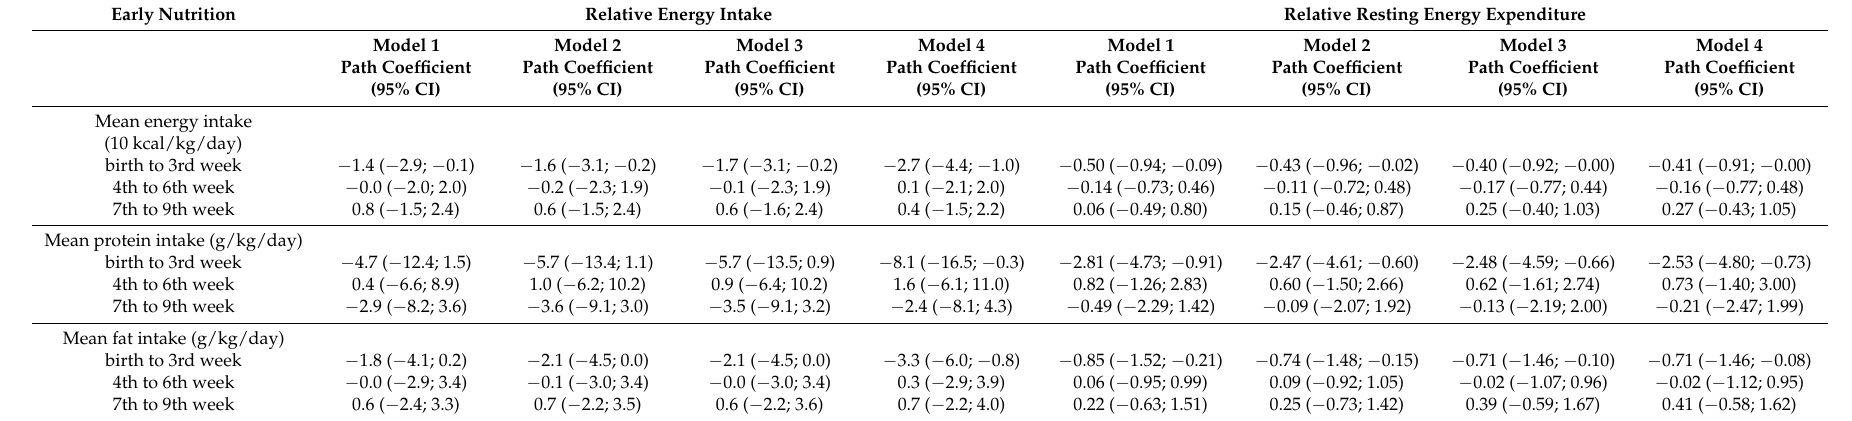
Table 3. Path coefficients and 95% bias corrected confidence intervals from models including the outcome and one nutrient intake variable (total energy, protein or fat intake) during all three time